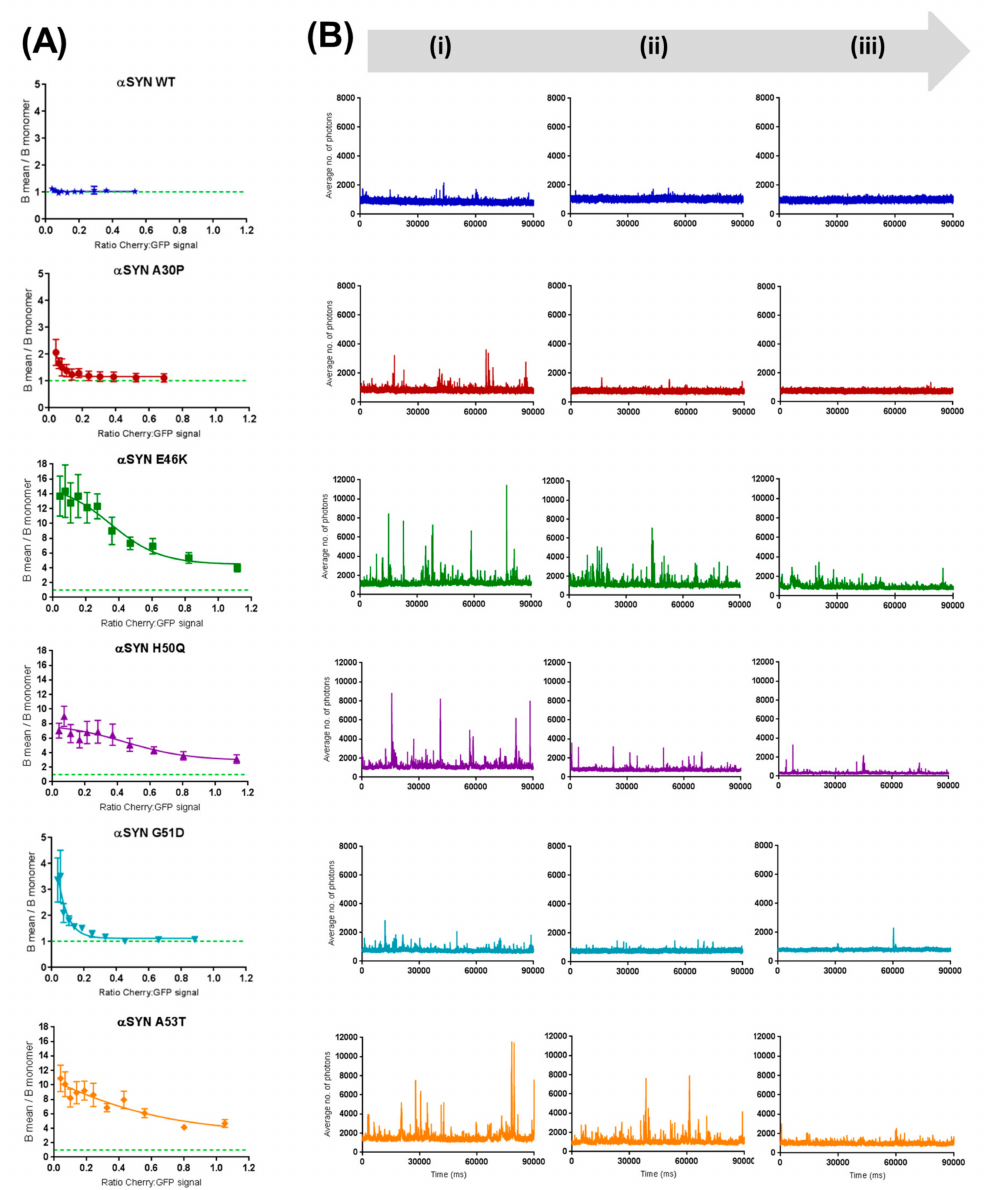
Figure 2. Brightness analysis of α -synuclein mutants reveals selective inhibition of their pathological aggregation by β -synuclein. ( A ) The brightness parameter was calculated for the GFP tagged proteins and plotted against the the mCherry β -synuclein: sGFP α -synuclein ratio (0 < ratio Cherry:GFP < 1.2). For each ratio, three 30 s replicates were acquired and averaged for a total of four co-expression experiments for each protein. The brightness of the GFP monomer is indicated by a green dashed line. Error bars represent the SE of those 4 independent measurements. ( B ) GFP fluorescence time traces show the inhibition of α -synuclein aggregation from ( i ) the initial control C-terminal sGFP-tagged α -syn, to ( ii ) 1:3 of β syn-mCherry: α syn-sGFP and, finally ( iii ) 1:1 Cherry:GFP. Arrow indicates this increase in β : α